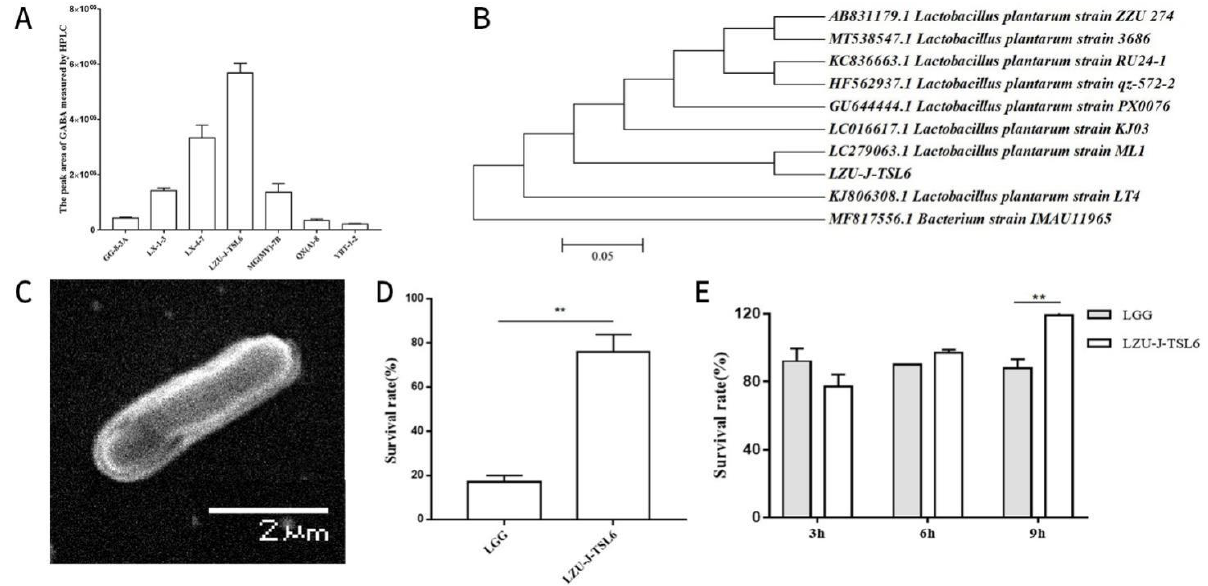
Figure 1. Screening and identification of the LZU-J-TSL6 strain: Quantitative detection of γ -aminobutyric acid (GABA) production ability of different strains by high-performance liquid chromatography ( A ), Phylogenetic tree of the LZU-J-TSL6 strain and related bacteria ( B ), Scanning electron microscopy morphology of LZU-J-TSL6 ( C ), and the ability of the LZU-J-TSL6 strain to resist acid ( D ) and choline ( E ) in vitro. Bars show the mean ± SD ( n = 3 parallel trials per group). ** p < 0.01.